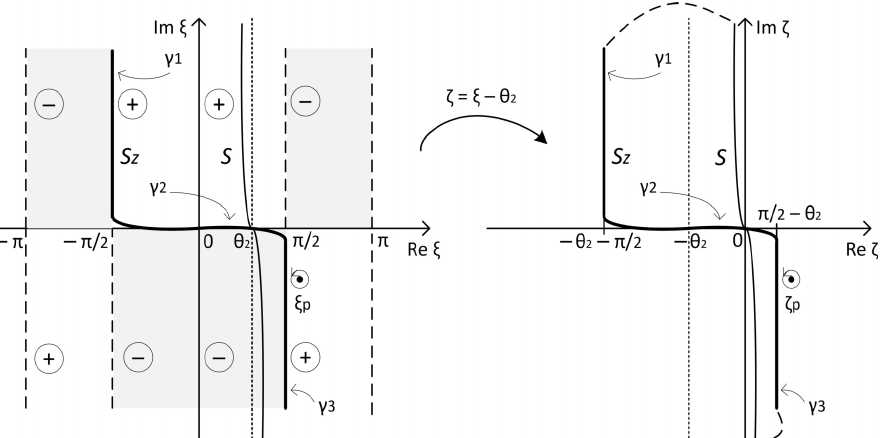
Figure 7. The contour of integration: (a) S z : original contour in the complex ξ -plane (left plot) and its ζ -plane mapping (right plot) (b) S : “Etalon integral” contour in the ζ -plane (right plot) and its ξ -plane mapping (left plot), (c) ξ p : relative position of the pole in the ξ -plane, (d) ζ p : relative position of the pole in the ζ